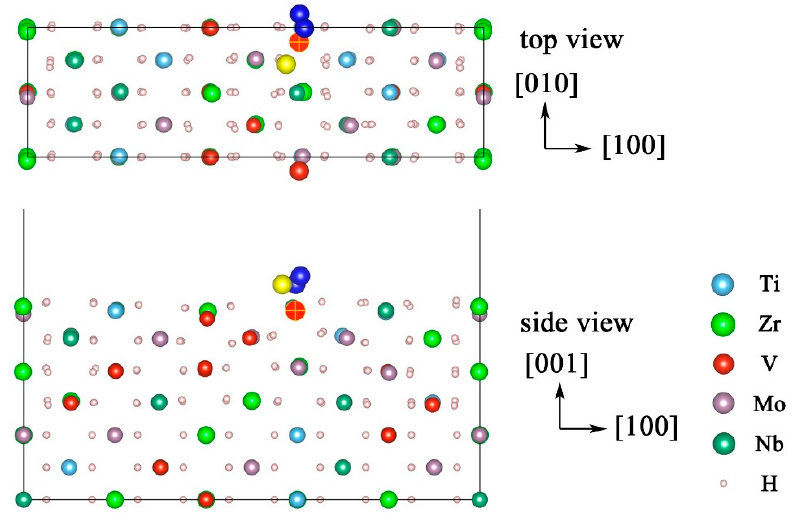
Figure 5. Schematic view of the third hydrogen atom dissociated from the TiZrVMoNb hydride (110) surface. The desorbed H atoms and the third dissociated hydrogen atom are represented by dark blue and yellow spheres, respectively.